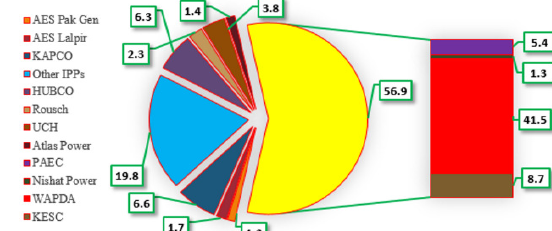
Fig. 4: Percentage share in electricity generation by